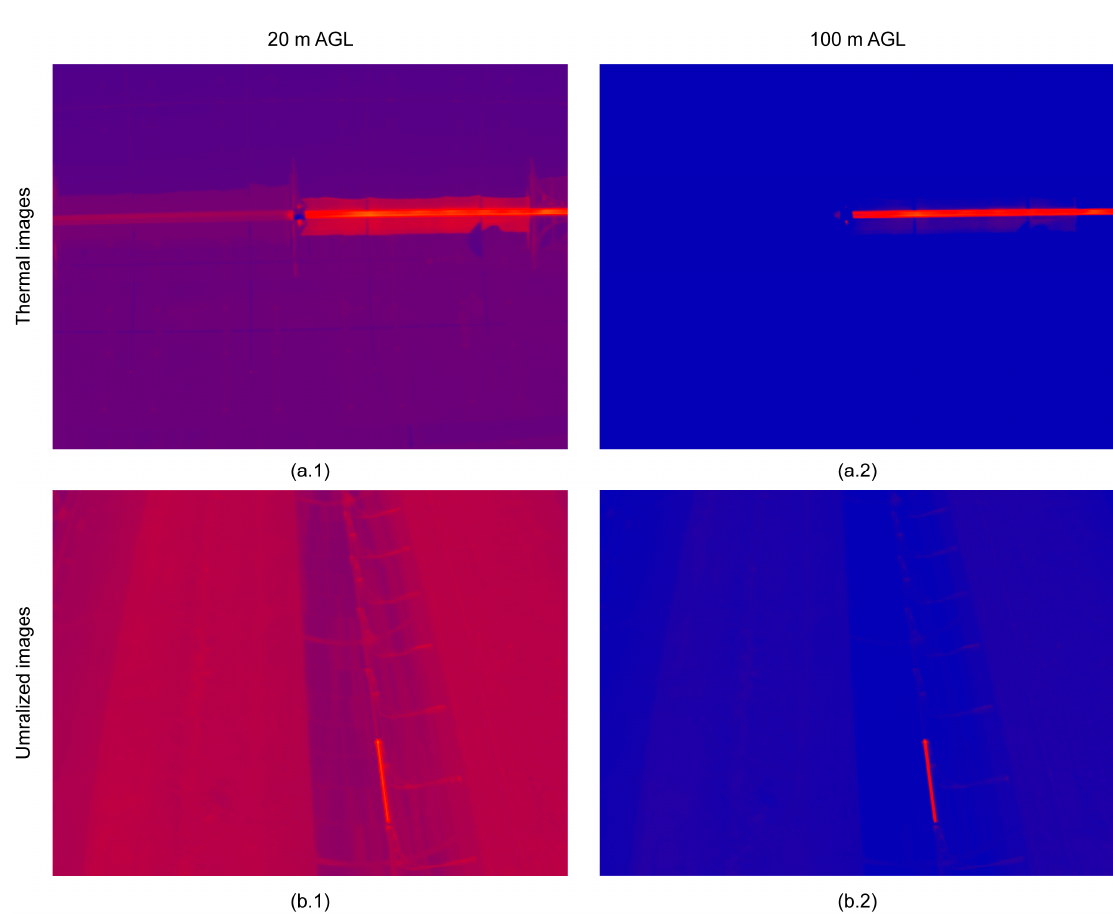
Figure 9. Examples of the UAV inspection at ( a ) 20 m and ( b ) 100 m AGL; ( 1 ) un-stretched and ( 2 ) stretched histograms.